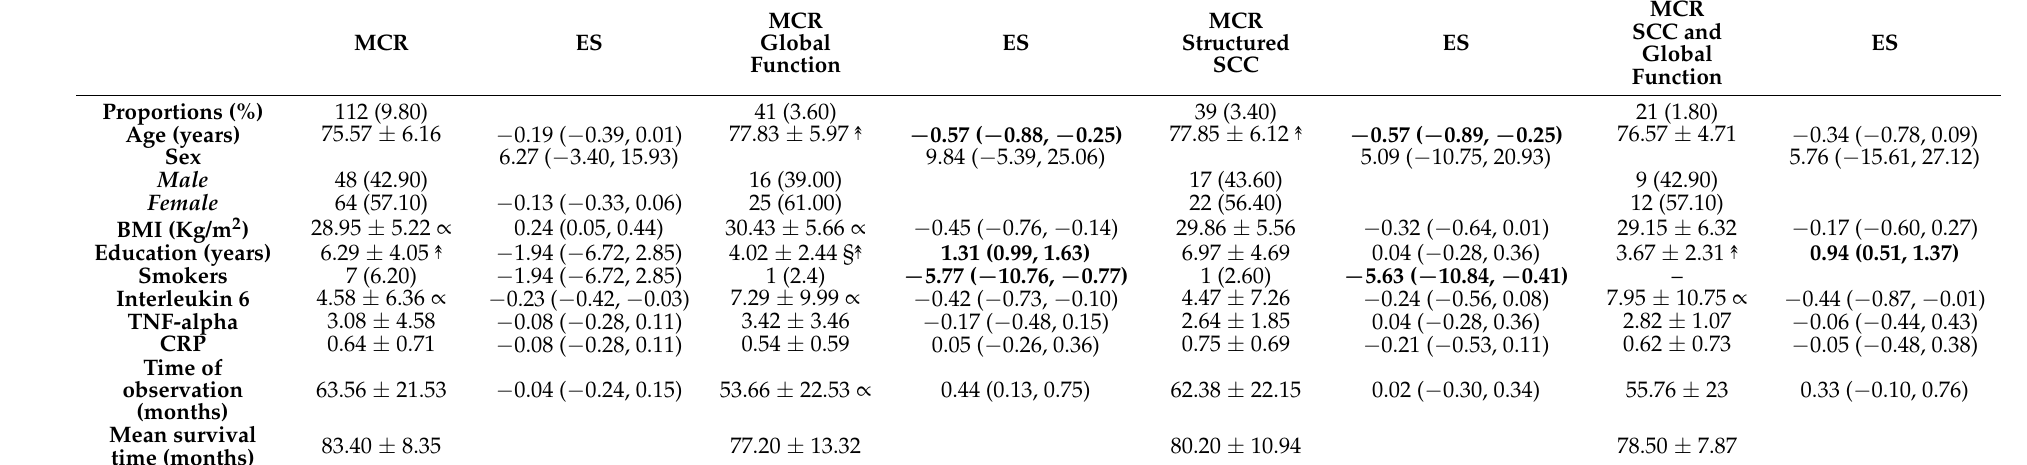
Table 1. Clinical characteristics of MCR subtypes * (N: 1138).